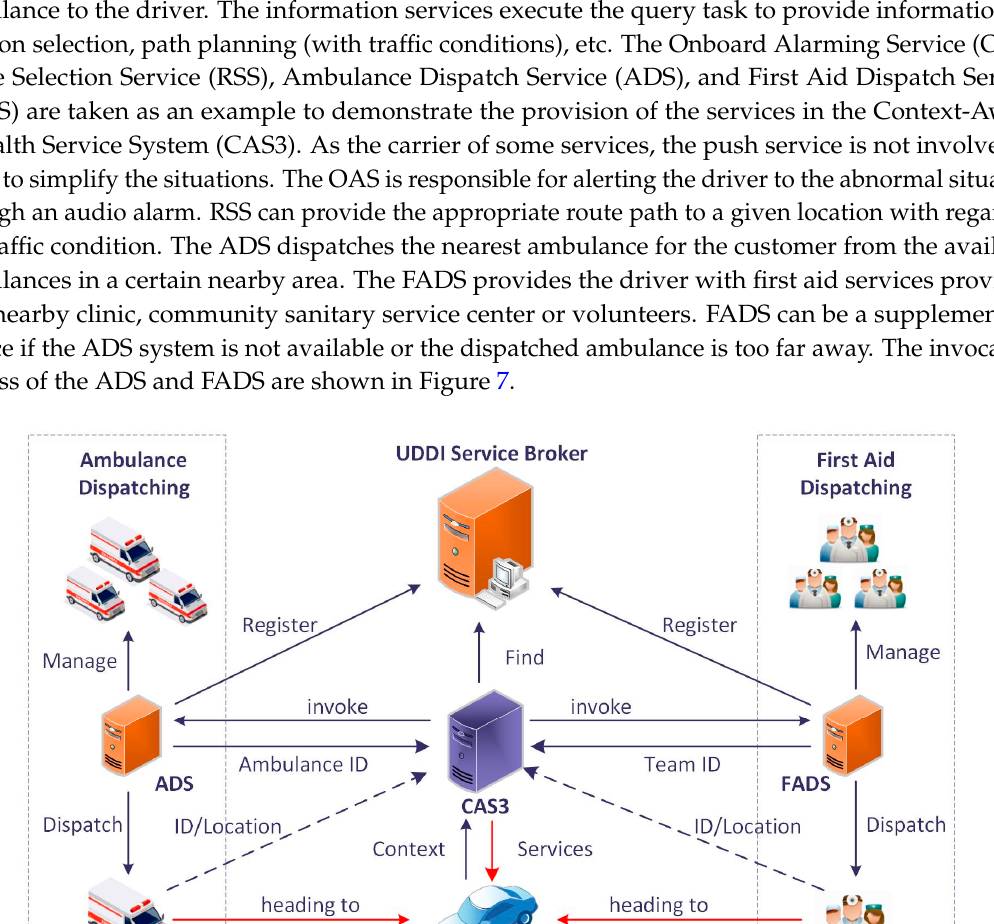
Table 4. Typical policies instances.